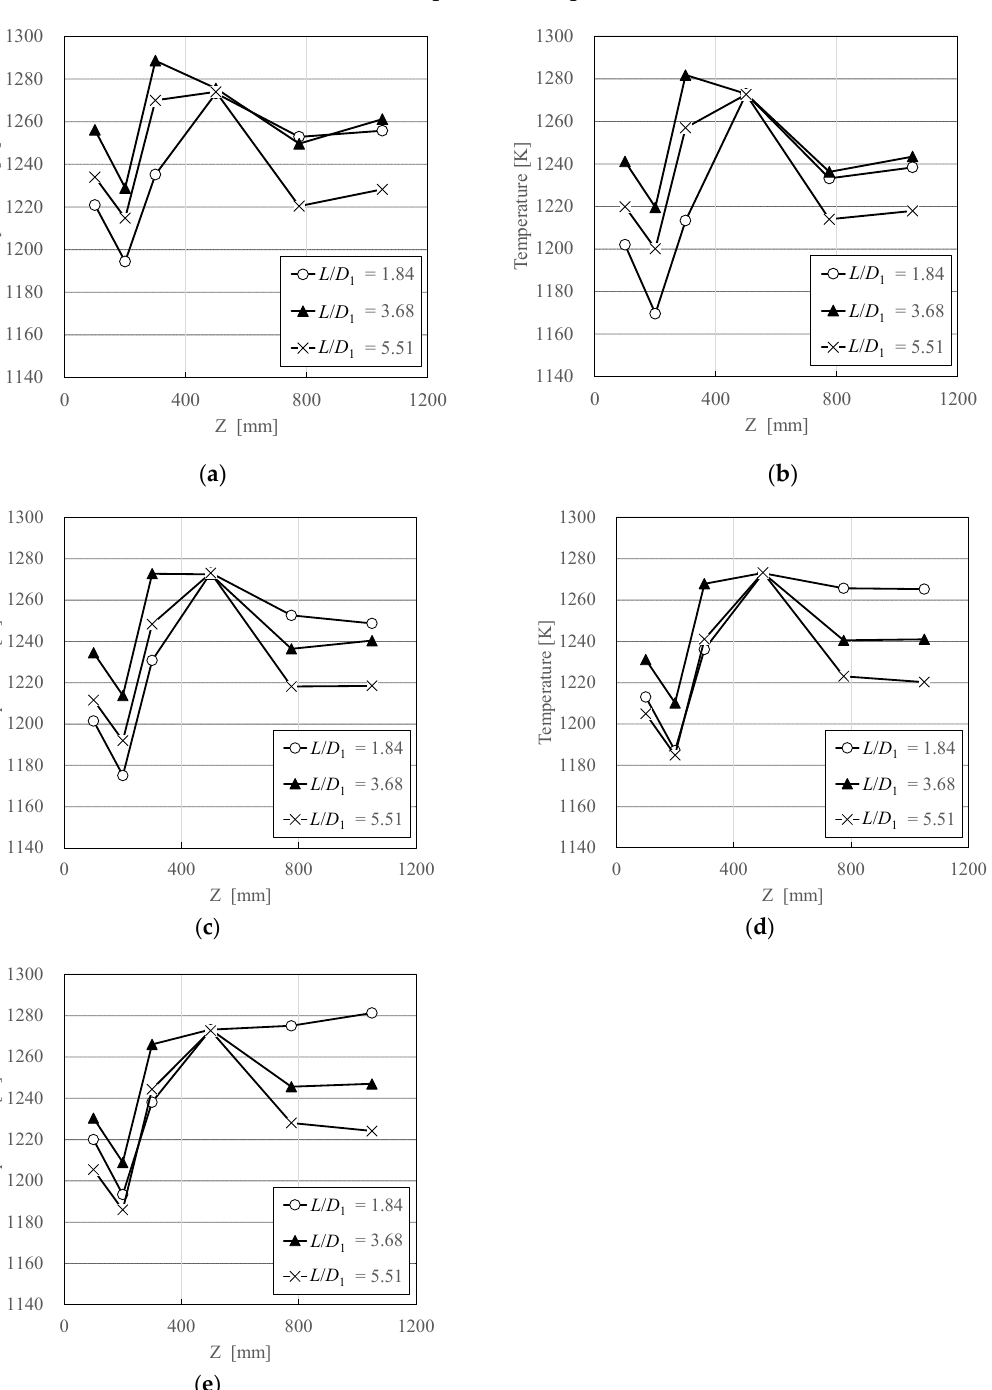
Figure 9. Comparison of NOx emissions rates for different L / D 1 . Input = 11.63 kW, λ total = 1.2, D 2 / D 1 = 0.24.